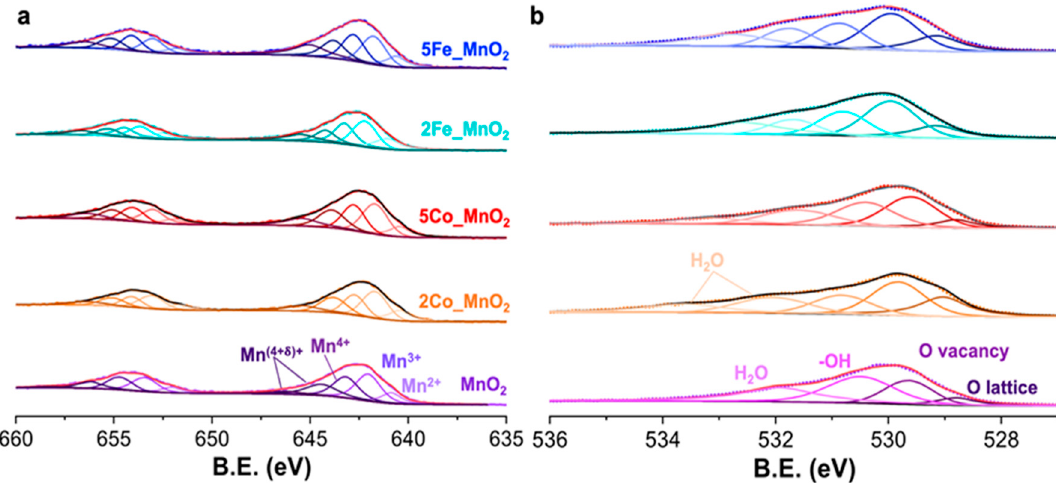
Figure 4. Fitted XP spectra of ( a ) Mn 2p and ( b ) O 1s regions relative to bare, Co- and Fe-doped MnO 2 samples.